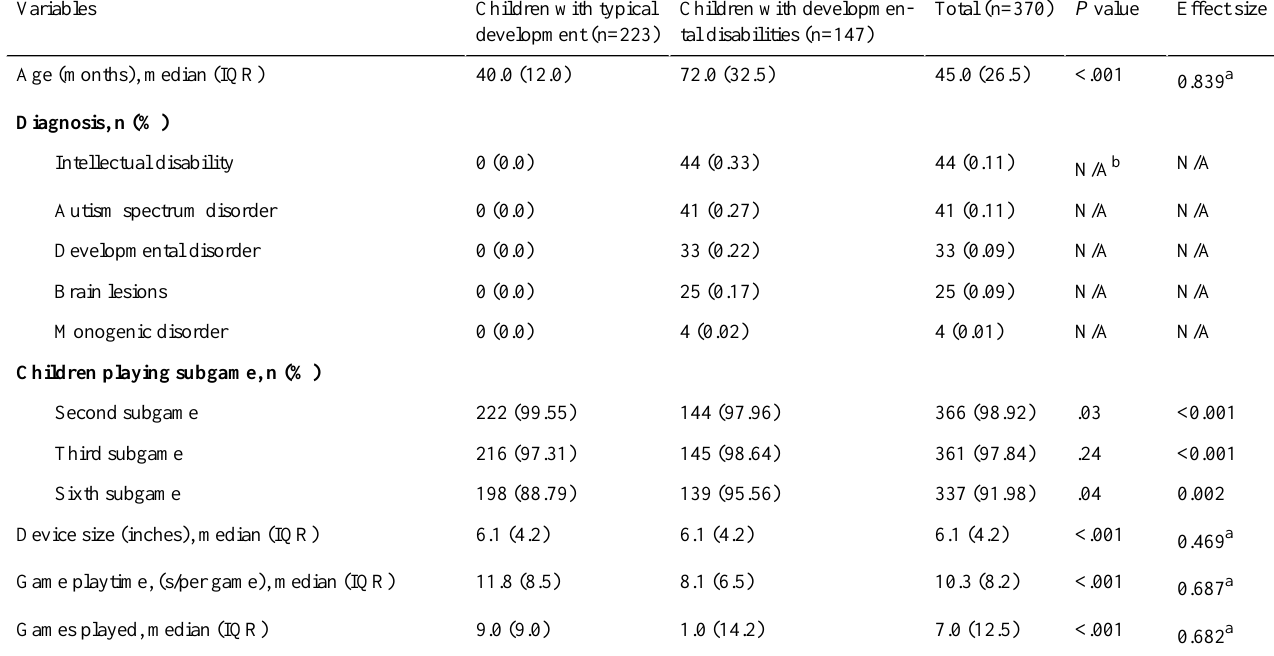
Effect size P valueTotal (n=370)Children with